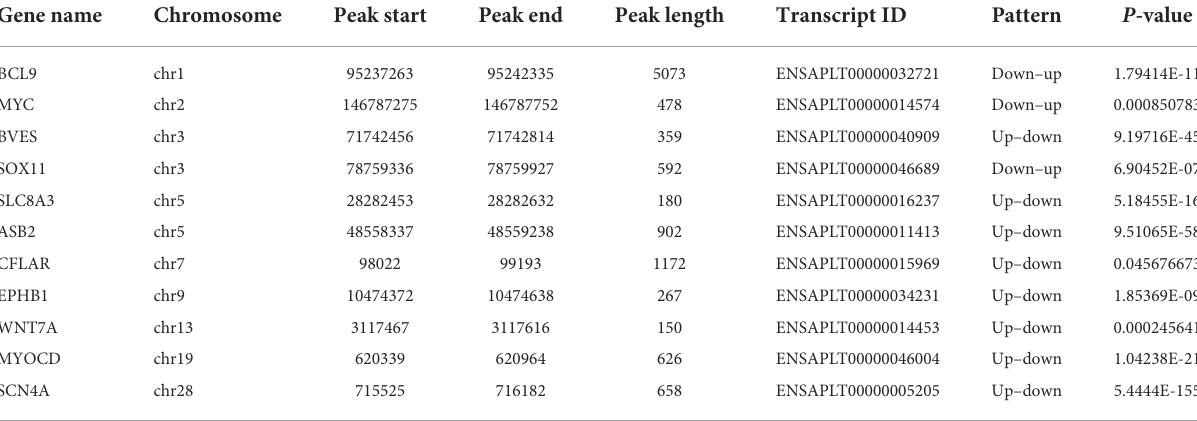
TABLE 3 List of 11 genes that exhibit a significant change in both m6A modification and mRNA expression related to muscle development in duck embryonic breast muscle